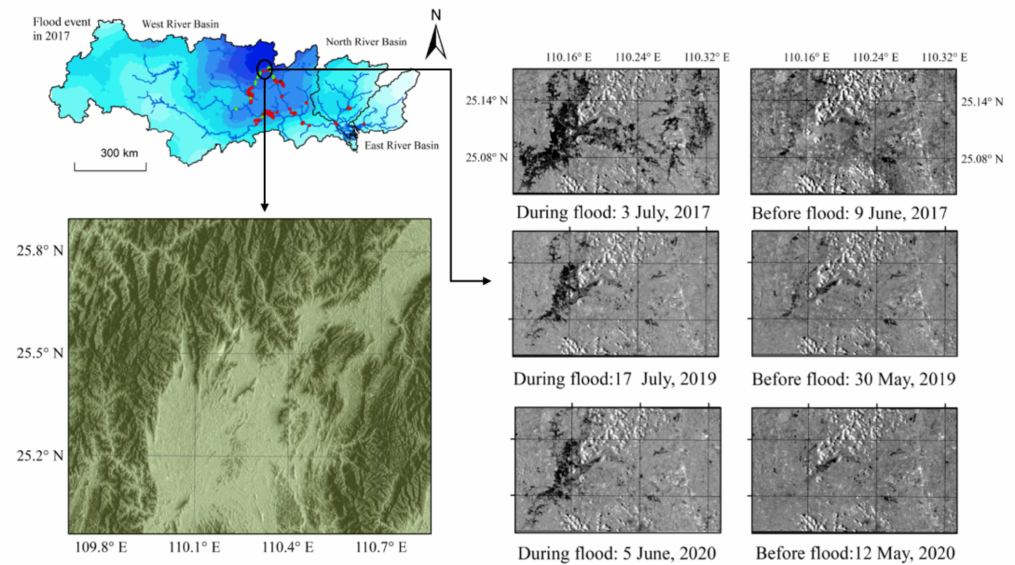
Figure 7. Locations are mainly affected by flooding in Guilin, Guangxi Province, China. Lower left panel is the integration between the DEM map and the hill shade map.